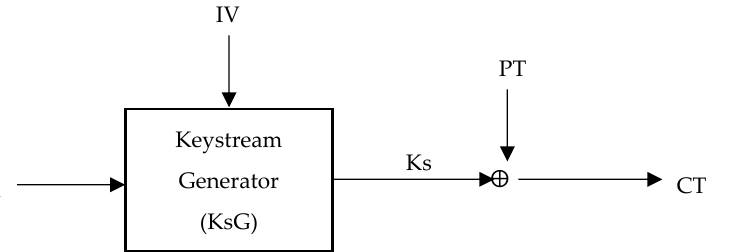
Figure 1. Stream cipher encryption operation.